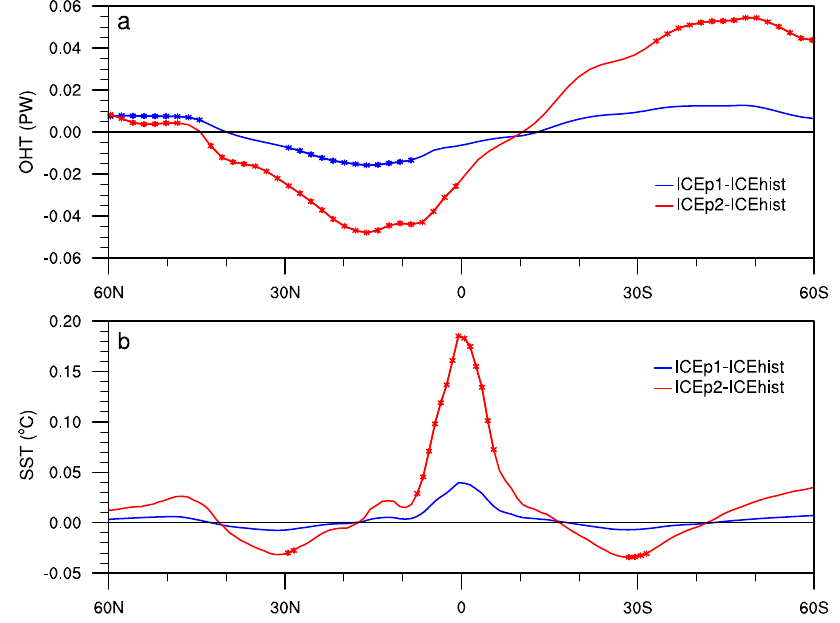
fi xed Arctic sea ice during 2080 – 2099 (ICEp2) and ICEhist (red line). b Regression ofthezonallyaveragedSSTdifference(°C)inthePaci fi cbetweenICEp1andICEhist (blueline)andbetweenICEp2andICEhist(redline)onthecorrespondingaveraged Paci fi cOHTin( a ).Statisticallysigni fi cant(>95%con fi dencelevel)valuesaremarked by